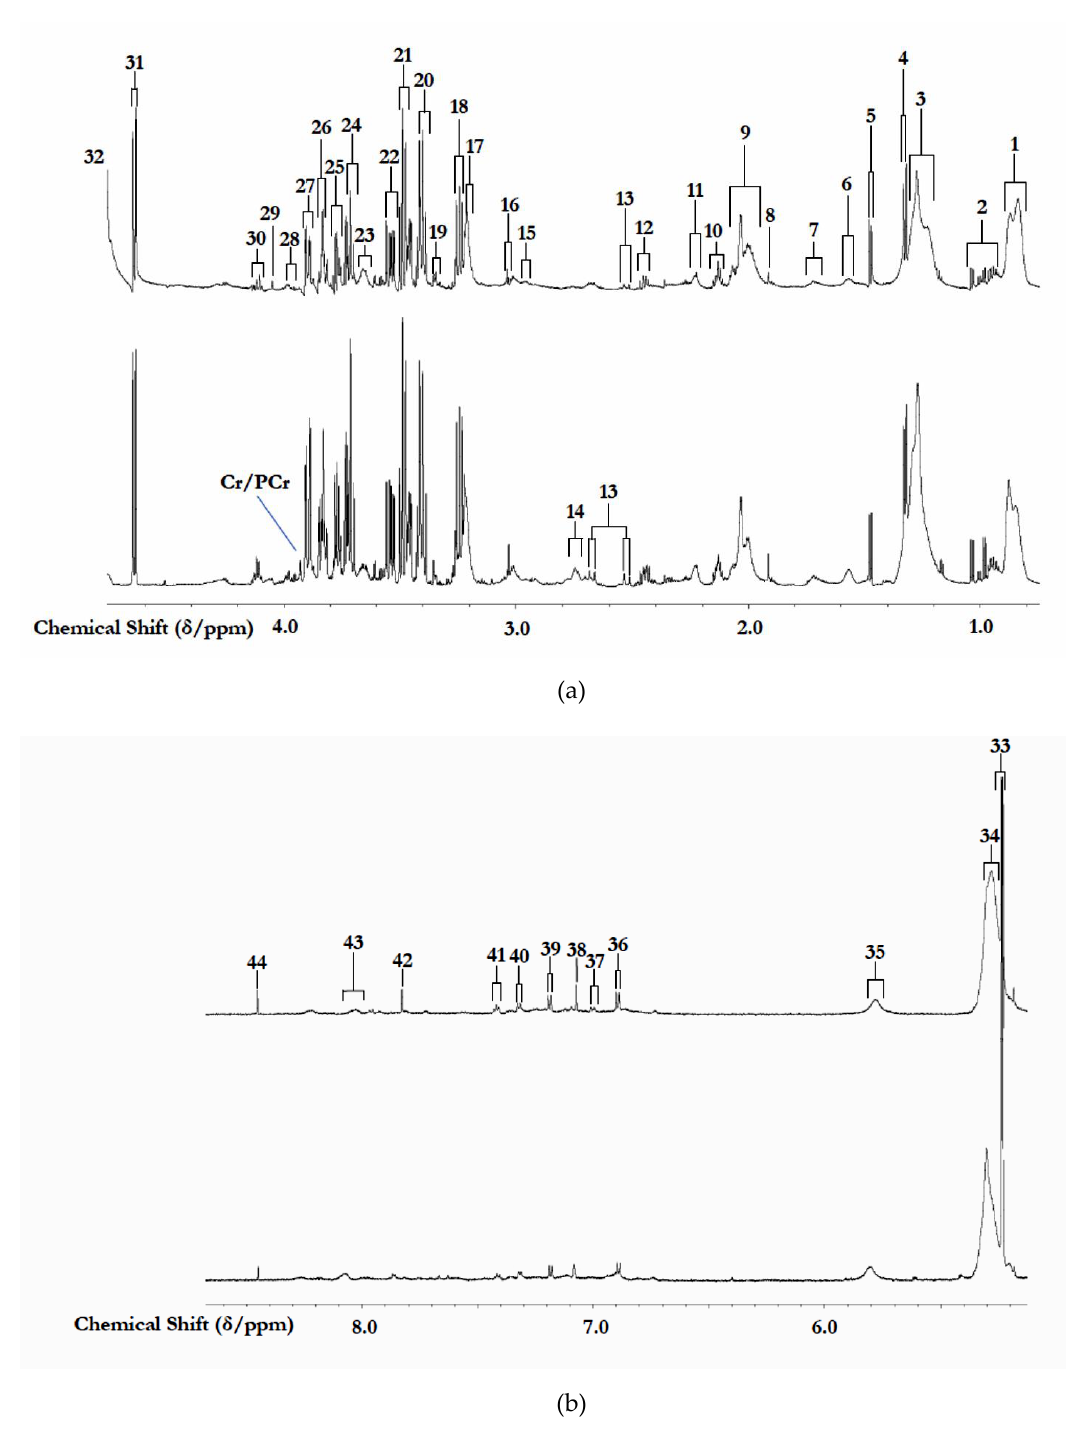
Figure 1. ( a ) and ( b ), expanded 0.75–4.40 and 5.00–8.70 ppm regions, respectively, of 700 MHz CPMG 1 H NMR profiles of HC (top) and GM1T2 (bottom) plasma samples. Typical spectra are shown. Numerical and abbreviated resonance assignments correspond to the codes provided in Table 1. GM1T2 disease-mediated upregulations in plasma creatinine and lactate concentrations are clearly visible from the intensities of their N-CH 2 - ( s ) and -CH(OH)- ( q ) resonances located at δ = 4.05 and 4.13 ppm (assignments 29 and 30), respectively.